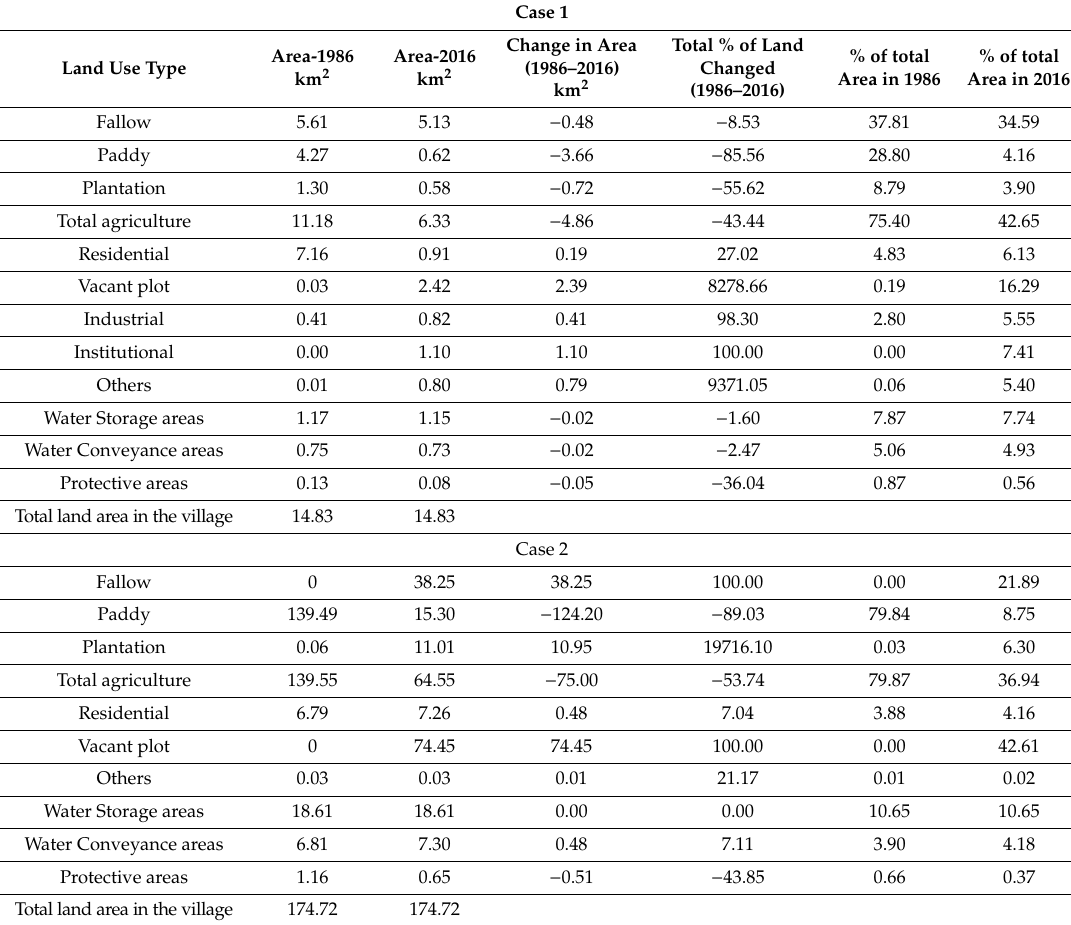
Table 1. Details of area under each land use